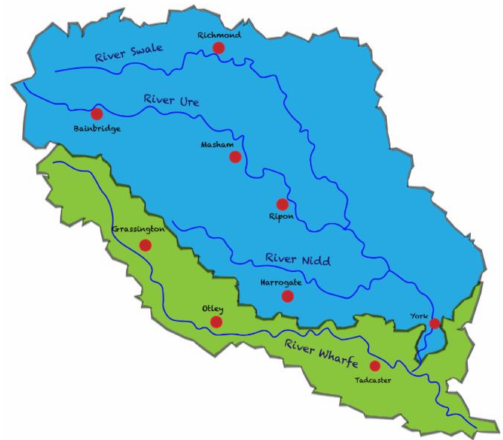
Figure 2. Dales to Vales River Network showing the Wharfe and Lower Ouse catchment (green) and Swale, Ure, Nidd and Upper Ouse catchment (blue)